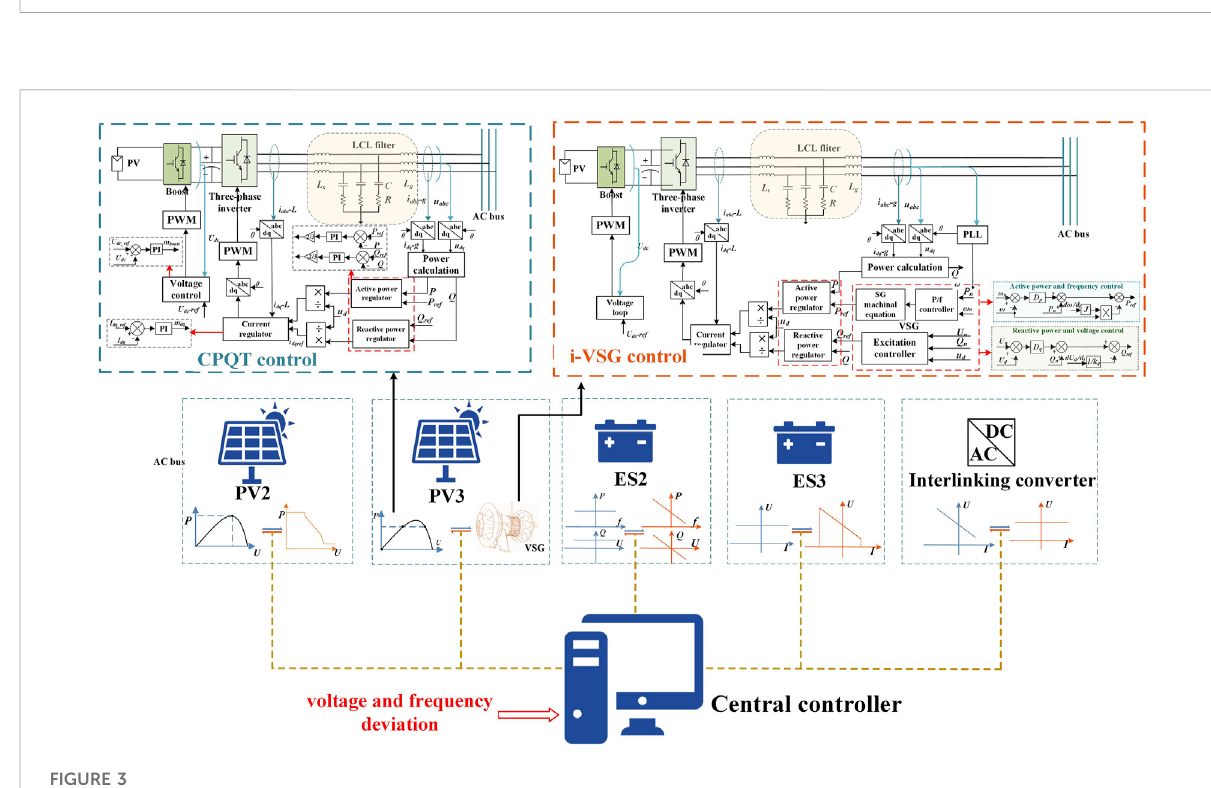
FIGURE 3 The control diagram of